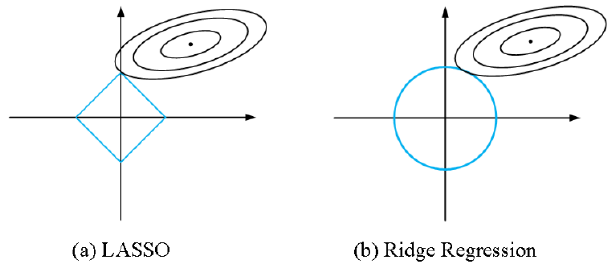
Figure 1. Visualization of objective function under different norm constraints.